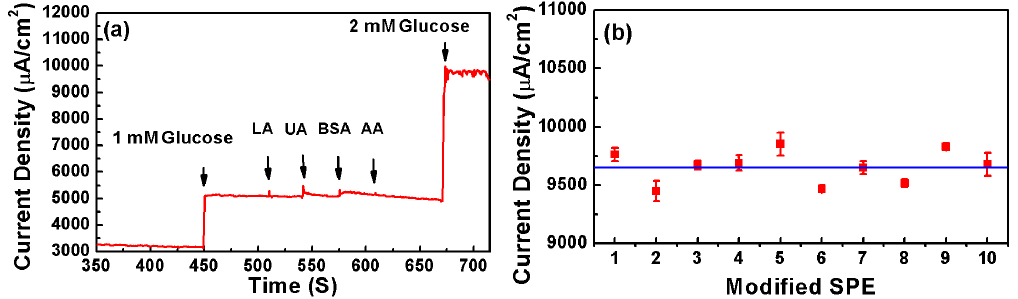
Figure 6. ( a ) Selectivity measurement of amperometric responses to successive addition of 1 mM glucose, 0.1 mM LA, 0.1 mM UA, 0.1 mM BSA, 0.1 mM AA, and 2 mM glucose; ( b ) Reproducibility measurement of 10 amperometric response towards 3 mM glucose.